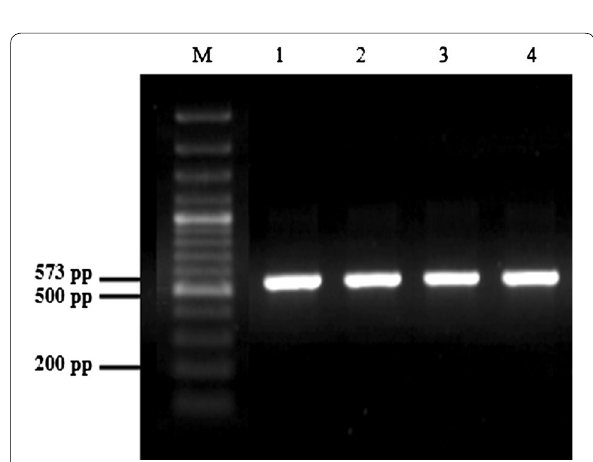
Fig. 3 Detection of plnA sequences in Lactobacillus plantarum. Detection of plnA sequences in 4 Lb. plantarum isolates. Lane M: molecular weight marker 1kb; Lane 1: M16; Lane 2: M17; Lane 3: M18; Lane 4: M19